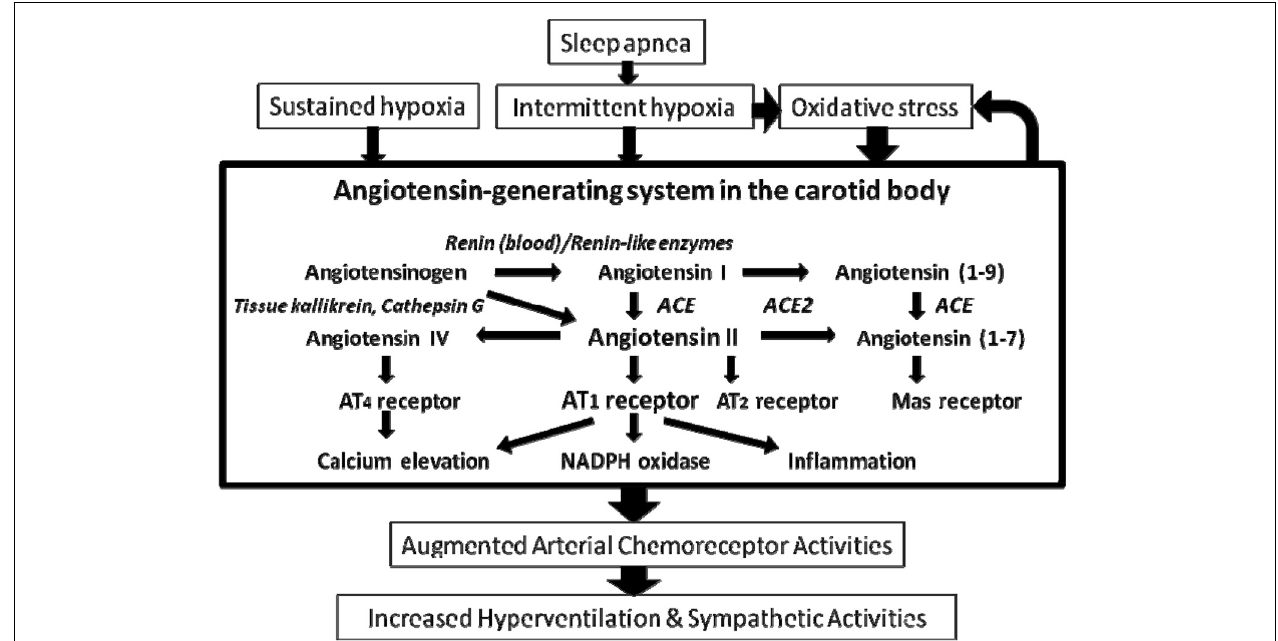
FIGURE 1 | Main components of the renin angiotensin system and the enzymes mediating the proteolytic process in the carotid body. Arrows denote the main direction of the physiological or pathophysiological cascade. Note the renin-independent biosynthetic pathway and the enzymes involved